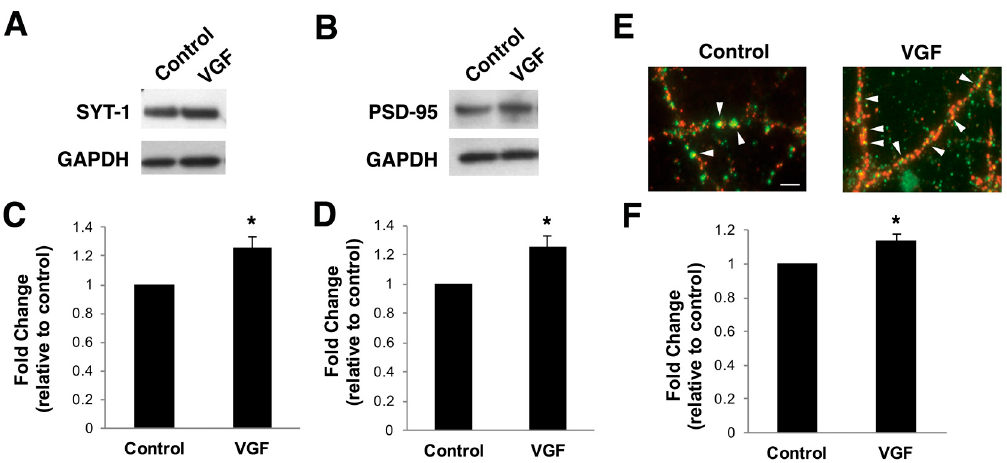
Figure 3. TLQP-62 peptide enhances the levels of synaptic proteins and synaptic contacts. ( A , B ) Representative Western blot of hippocampal cultures (14 DIV) that had been pretreated with vehicle or TLQP-62 (3 µM) for three days. Protein lysates were run on a 4%–12% NuPAGE Tris gel and the membrane probed for either synaptotagmin (SYT-1) ( A ) or PSD-95 ( B ) followed by GAPDH for loading control; ( C ) quantitation of SYT-1 protein expression. Bars represent average protein expression compared to control ± SEM ( n = 7); ( D ) Quantitation of PSD-95 protein expression. Bars represent average protein expression compared to control ± SEM ( n = 6) * p < 0.05 relative to control (unpaired t -test); ( E ) representative images of immunostained hippocampal cultures (17 DIV) treated with vehicle or TLQP-62 (3 µM) for three days. The cultures were probed for synaptotagmin (SYT-1) ( red ) and post-synaptic protein PSD-95 ( green ). Points of co-localization are indicated by white arrowheads. Scale bar = 10 µm; ( F ) quantitation of co-localization are shown in bar graph. Synapses were counted on three 50 µm secondary dendrite segments per neuron ( n = 60). Bars represent average synapses per dendrite relative to the control of each set ± SEM ( n = 4). Two-sample t -test of control vs. VGF: ( C ) SYT-1 t(18) = 1.37 p = 0.014, ( D ) PSD-95 t(10) = 1.57 p = 0.011, and ( E ) synapses t(148) = 1.30 p = 0.010. * p < 0.05 relative to control (unpaired t -test).